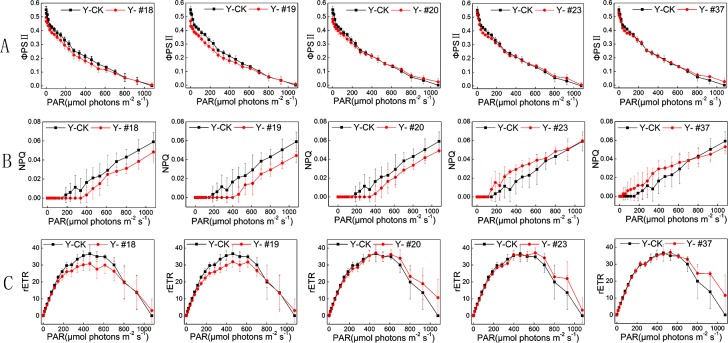
Chlorophyll fluorescence parameters of the progenies and of the control group.A: RLC of PSII quantum yield of the five progenies and of the control group. B: RLC of NPQ of the five progenies and of the control group. C: RLC of rETR of the five progenies and of the control group. The algal cells were exposed to different AL (1–1077 μmol photons m -2 s -1). Measurements were performed in darkness before at room temperature, and each light step was applied every 20 s. OD 680 nm of the five progenies and of the control group showed no significant differences on the 12th day of cultivation (p < 0.05). n = 3+SD.